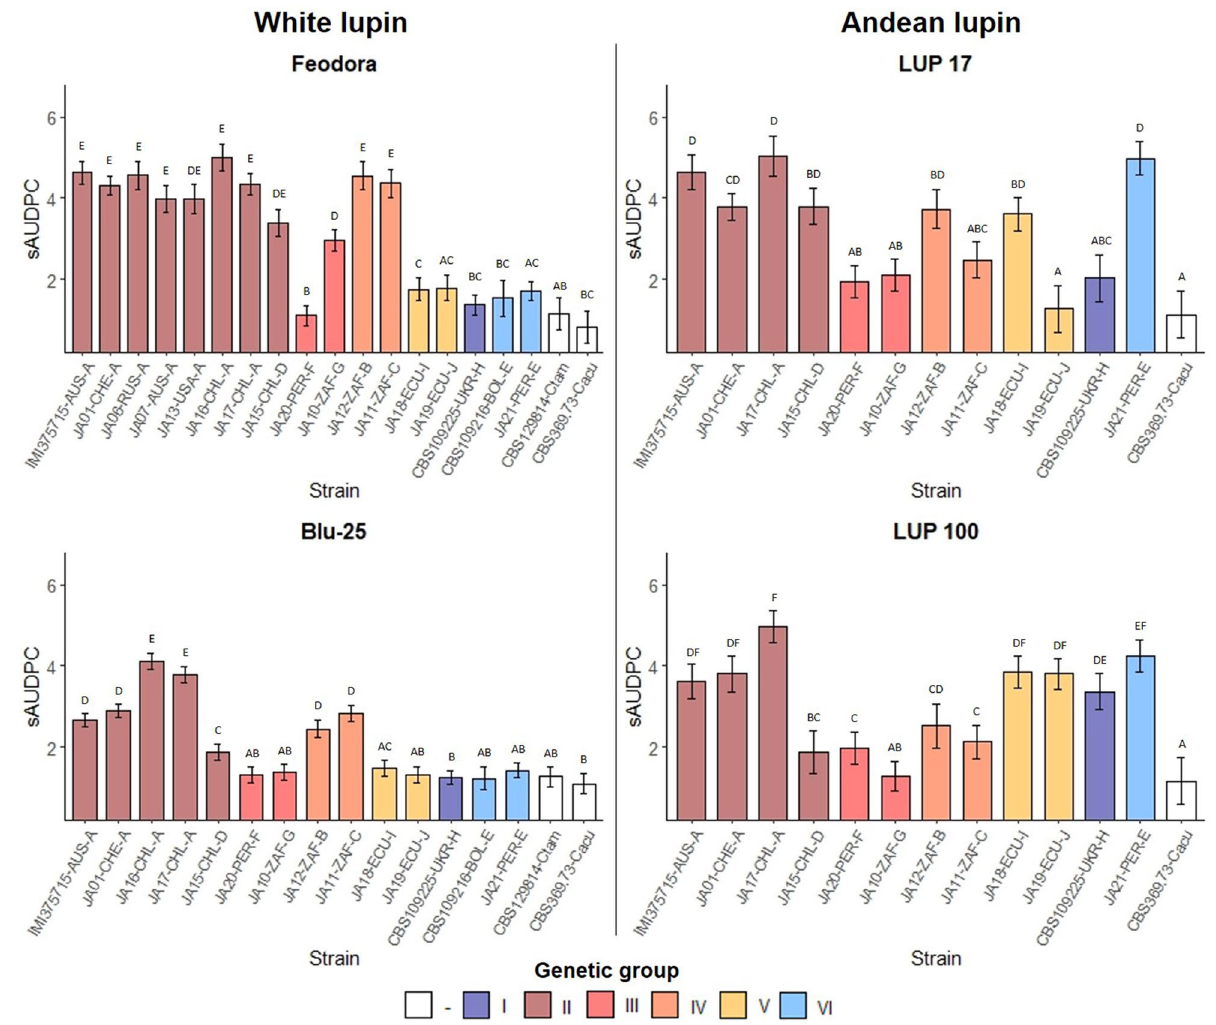
Figure 4. Virulence of Colletotrichum lupini strains on white ( Lupinus albus) and Andean lupin ( L. mutabilis ). Anthracnose severity is expressed in standardized area under the disease progress curve (sAUDPC) and estimated means are shown. Strain codes are followed by abbreviated country of origin and morphotype (A–J). Different capital letters above bars indicate significant differences between strains (Tuckey-HSD, p < 0.05). Error bars indicate the standard error of the estimated